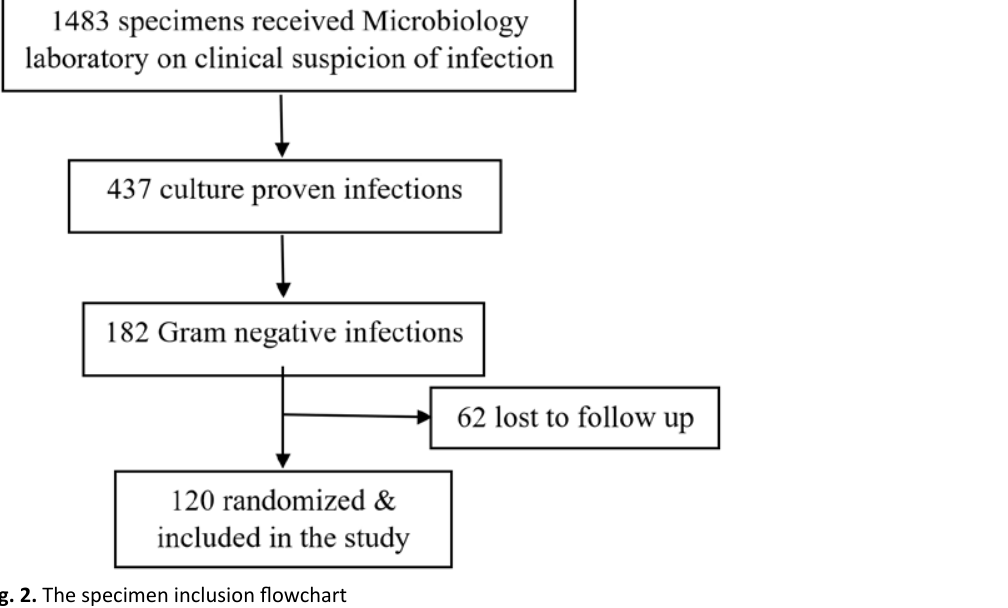
Fig. 2. The specimen inclusion